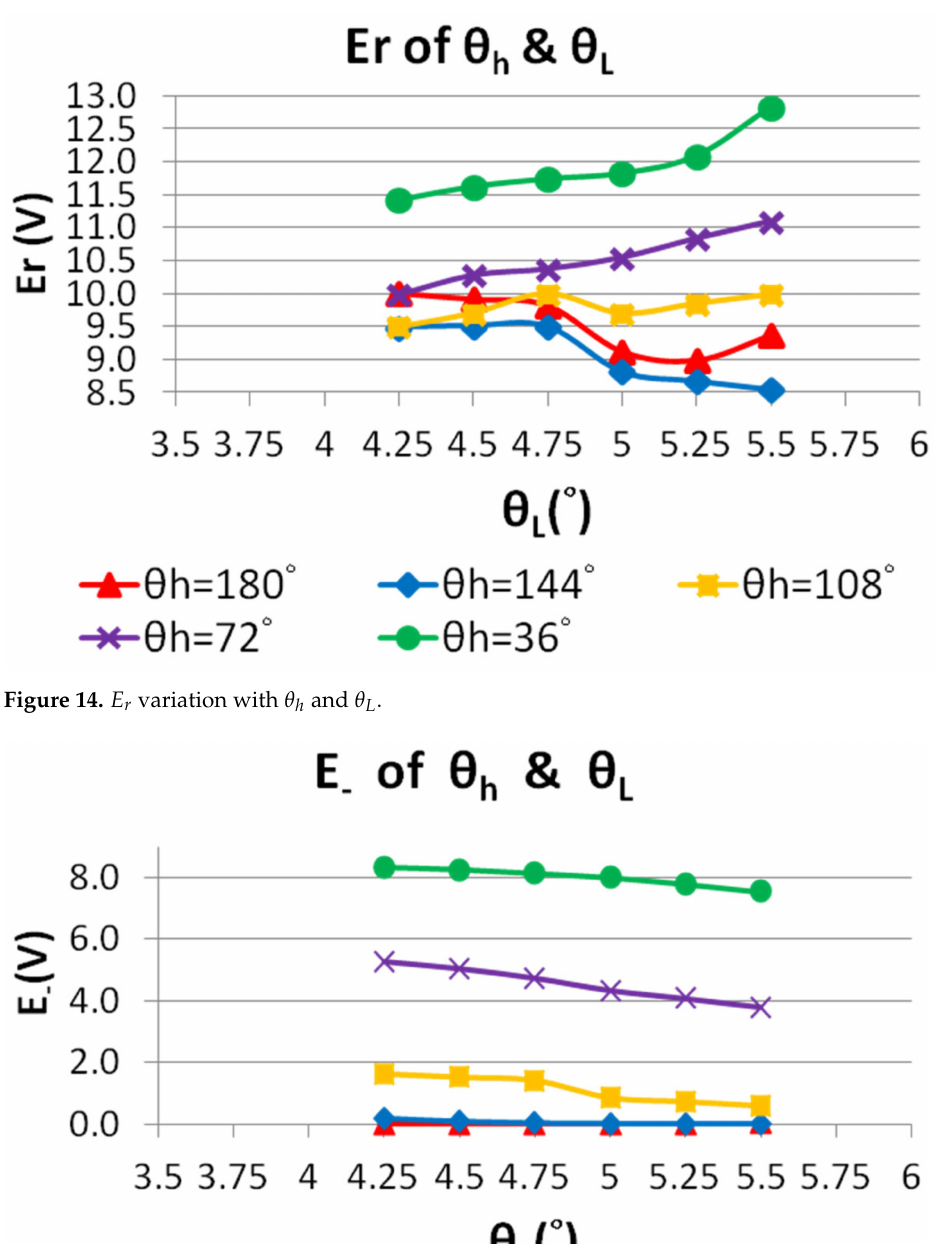
Figure 15. E − variation with θ h and θ L